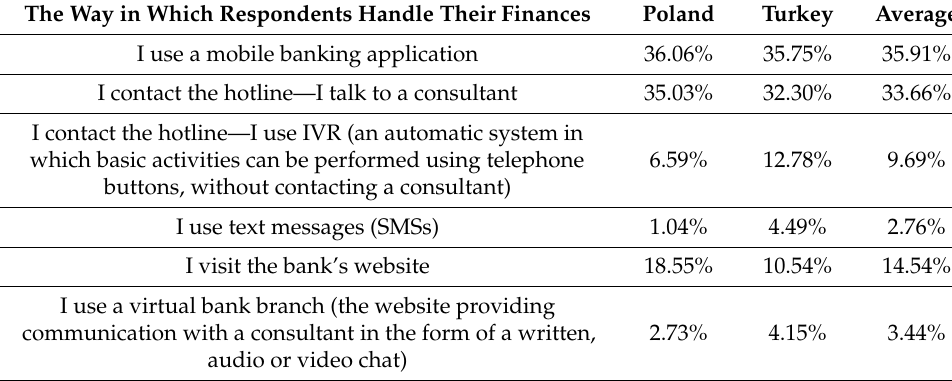
Table 2. Main methods of using mobile devices to access financial services in Poland and Turkey in 2021; source: own